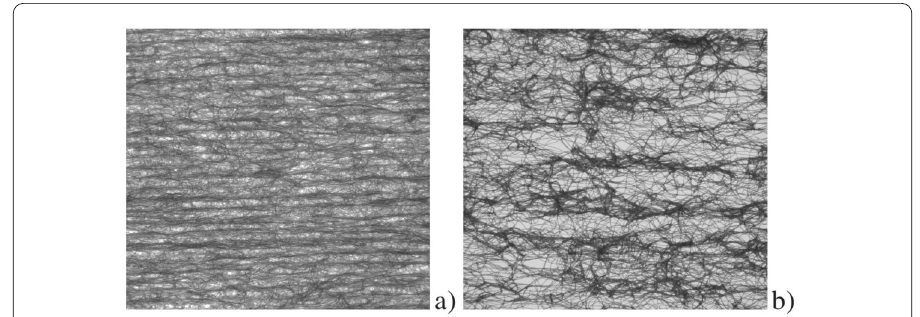
Figure 10 Images of the anisotropic nonwovens a) FL2 and b) FL3, 2048 × 2048 pixels of size 6.734 μ m. The